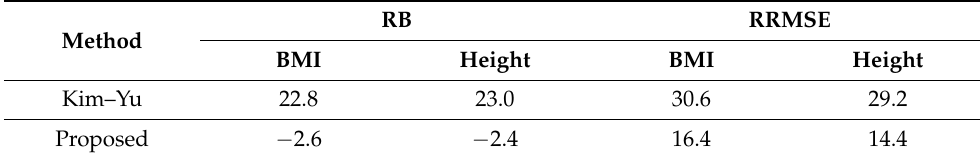
Table 6. The percent RBs and percent RRMSEs of the bootstrap variance